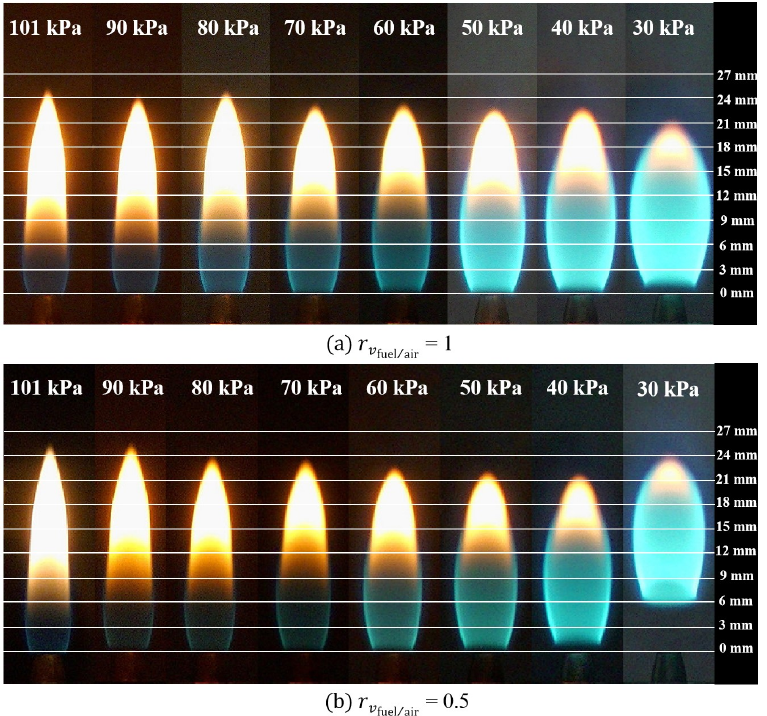
Figure 4. Pictures of coflow laminar diffusion flames from 101 kPa to 30 kPa. Propane flow rate was constant at 0.93 m/s; ( a ) r v ( fuel/air ) = 1; ( b ) r v ( fuel/air ) = 0.5 .